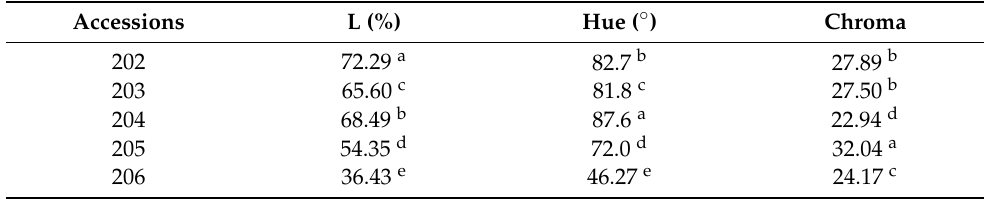
Table 2. Color grain of native maize from the Jalisco Highlands,